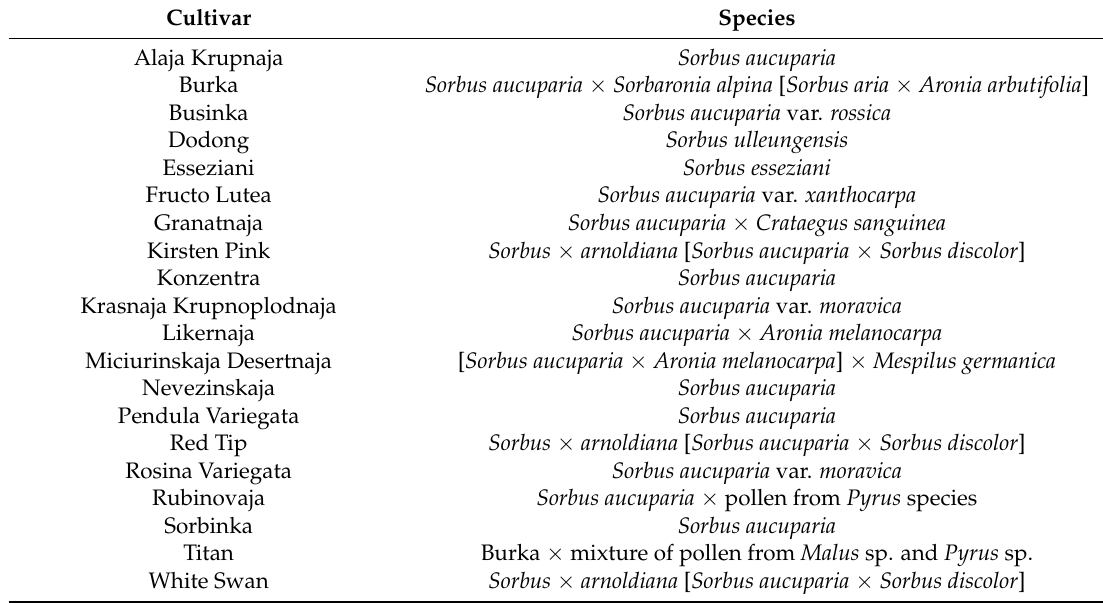
Table 5. Description of tested rowanberry species and